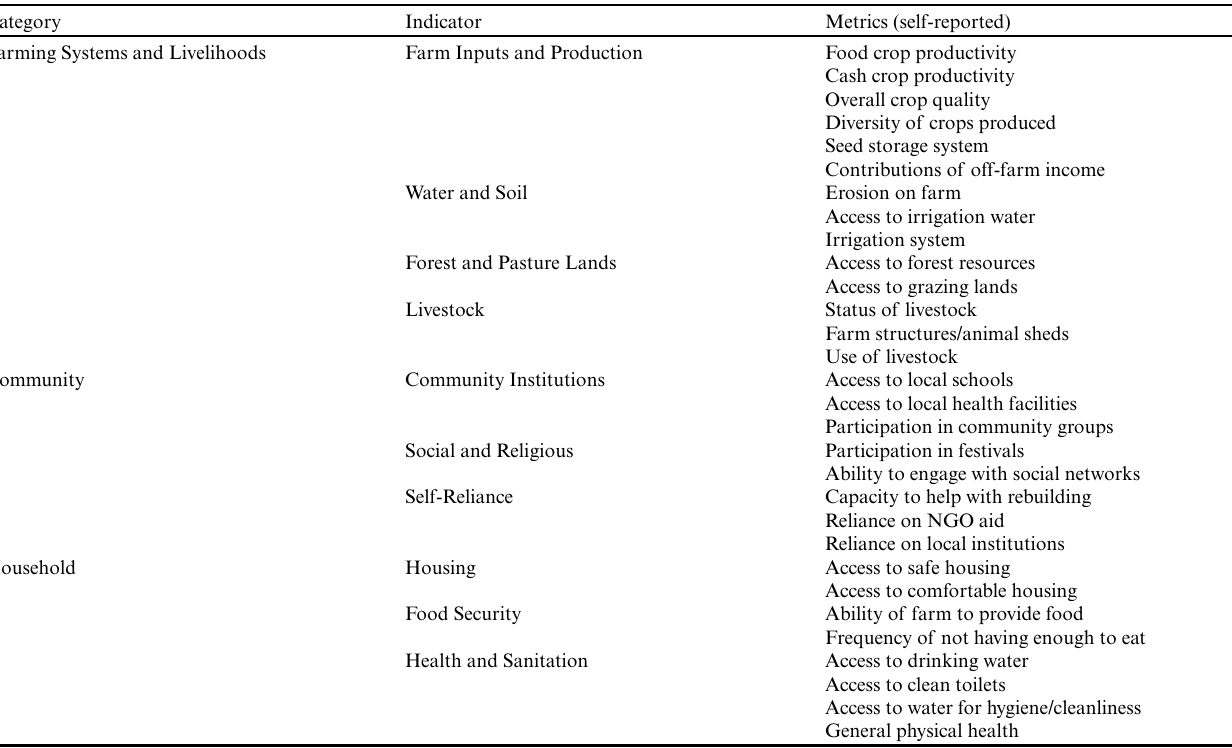
Table 1 . List of categories, indicators, and metrics within the “recovery assessment” used to track resilience following natural disasters for small-farm households (n = 79). Indicators are derived from the literature and adapted to the Nepali context. We recorded respondents’ self-assessment of whether they were doing better, worse, or about the same on each of these metrics at zero to six months after the earthquakes and one year after the earthquakes, compared to before the earthquakes.